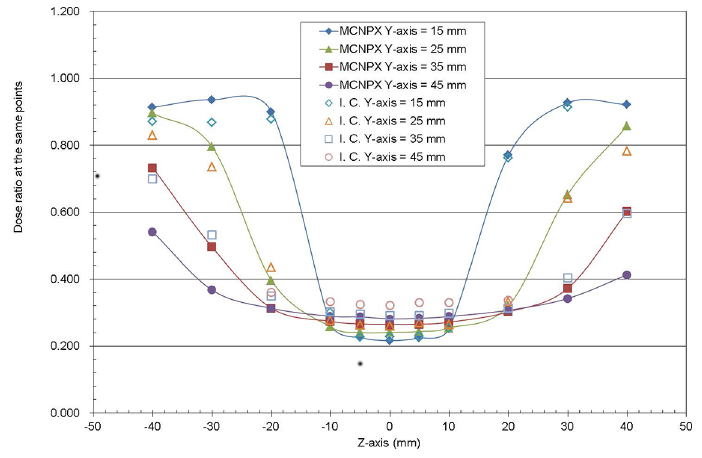
Figure 6. The ratio of dose with the presence of the ovoid and with the presence of the tandem.